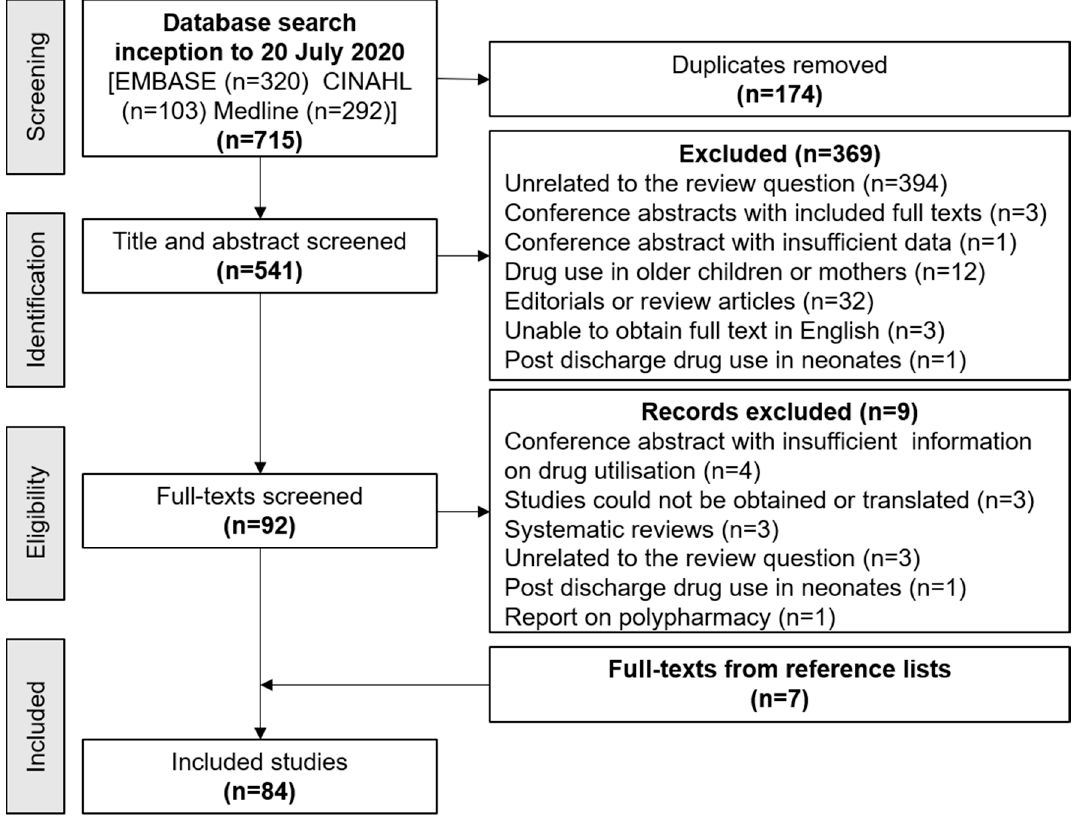
Figure 1. Selection of studies for inclusion.